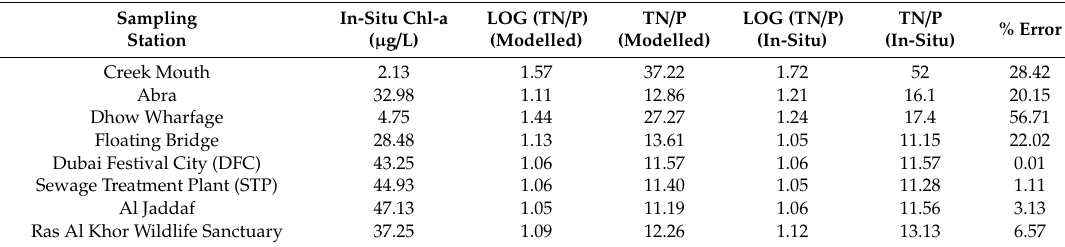
Table 5. Comparison of field and modelled TN / P.